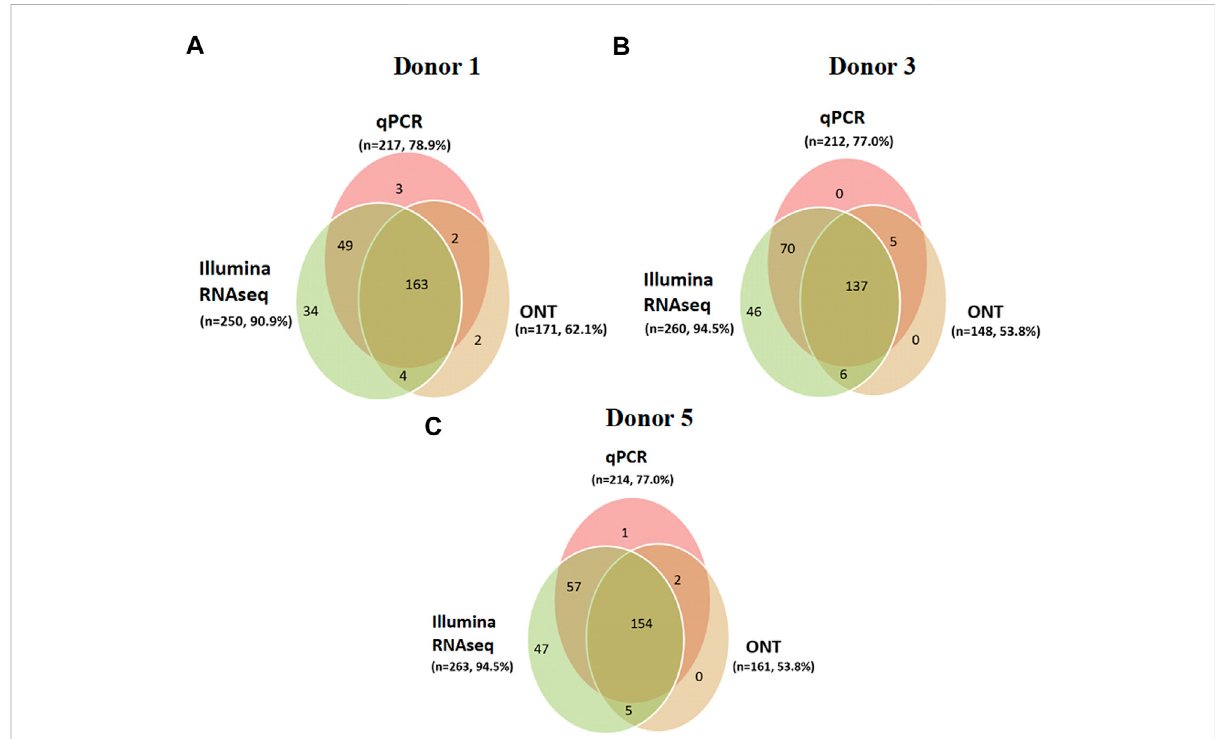
FIGURE 5 Donor-centric transcriptomes (Illumina RNA-Seq (FPKM > 0), qPCR (number of cDNA copies per cell, S t ≤ 40), and ONT (TPM > 0)) of human liver tissue samples: (A) donor 1 ( n = 257), (B) donor 3 ( n = 264), and (C) donor 5 ( n = 266), indicating the transcripts encoded by the Chr18 genes ( n =